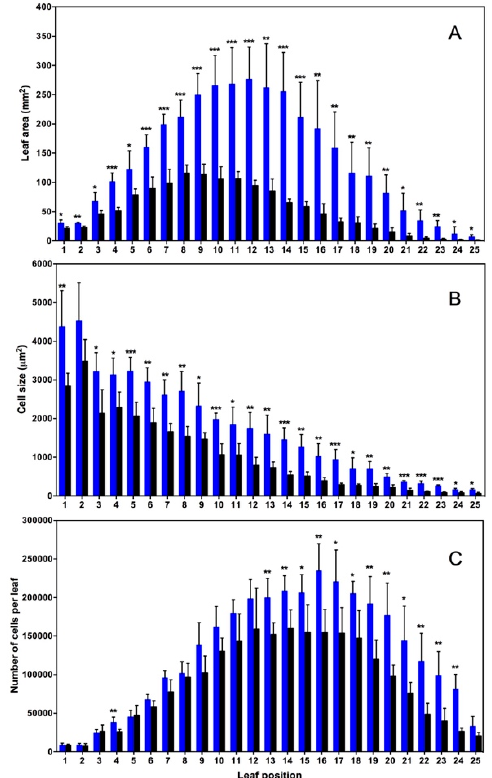
Figure 2. Area of leaves ( A ), size of cells ( B ), and number of cells ( C ) in 5-week-old Arabidopsis thaliana C24 plants as a function of leaf position. Plants were grown in the presence ( + NO 2 -treated plants, blue columns) or absence (–NO 2 control plants, black columns) of NO 2 . Values are expressed as means ± SD; n = 5. Statistical significance assessed by Student’s t -test (* P < 0.05; ** P < 0.01; *** P <